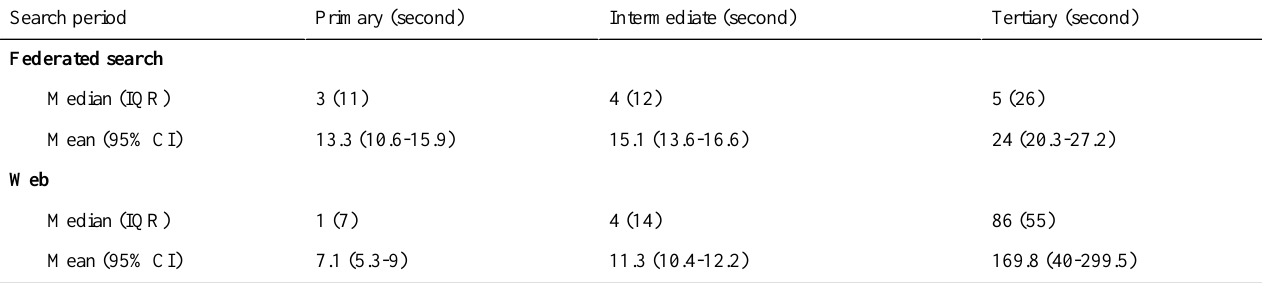
Tertiary (second)Intermediate (second)Primary (second)Search period